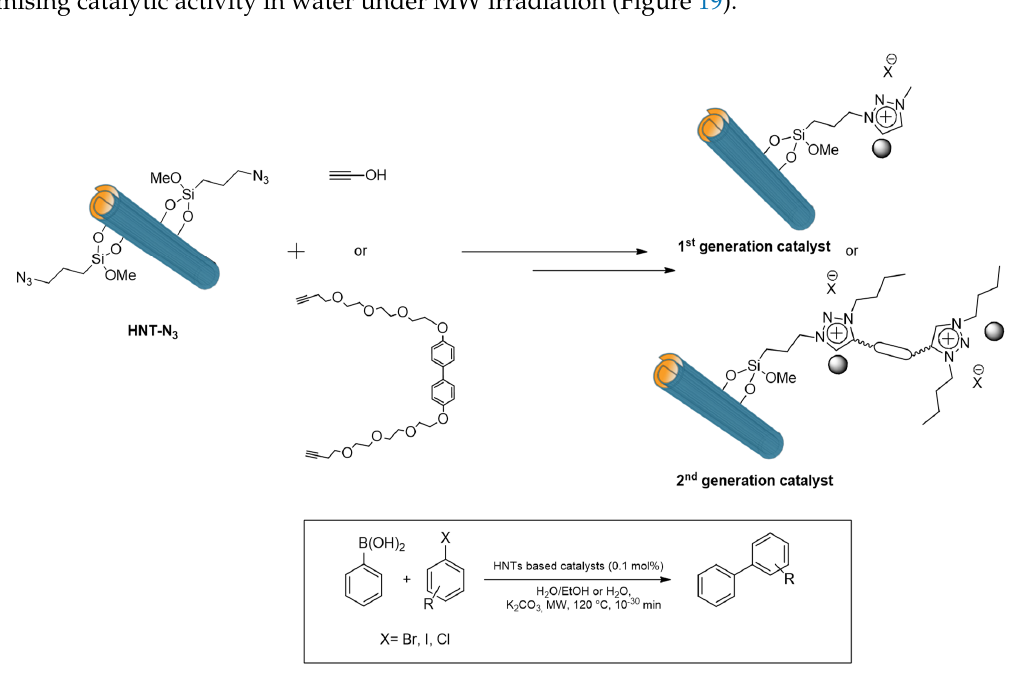
Figure 19. Synthesis of the first and second generation HNTs triazolium salt based catalysts and their application in the Suzuki reaction.